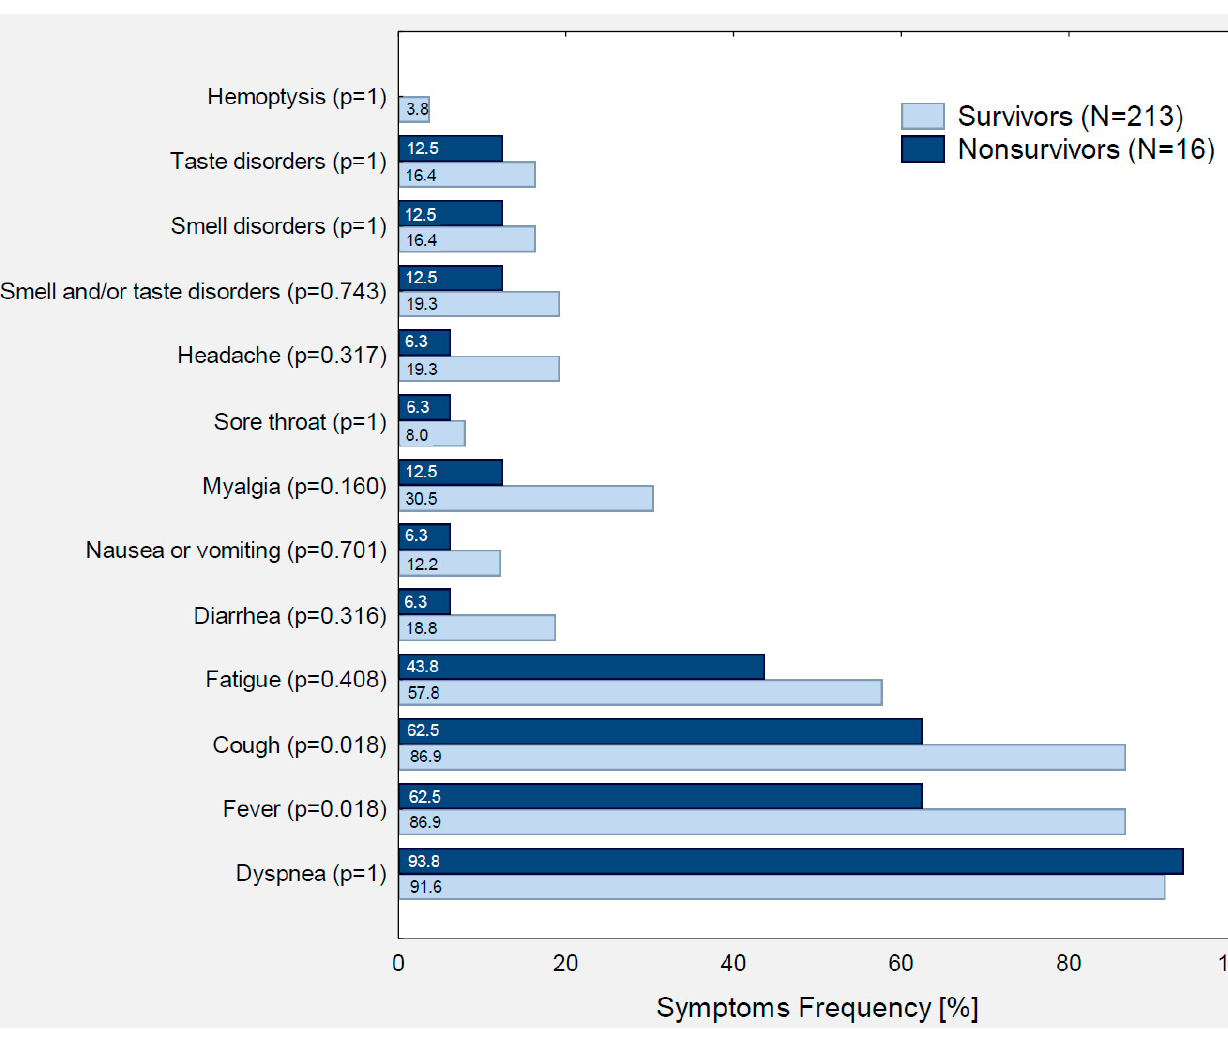
Figure 1. Comparison of symptoms frequency between survivors and non-survivors (presented as percentages, with p -values for each comparison).